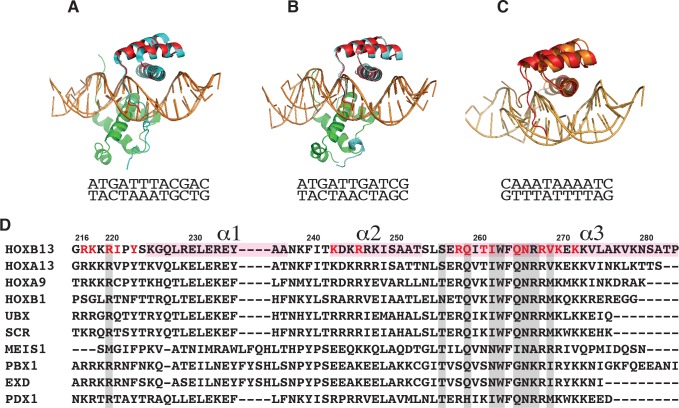
The comparison of HOXB13 structure with HOXB1 and HOXA9.The superposition of HOXB13-DNACAA complex (red) with: (A) HOXA9:PBX1-DNA complex (HOXA9 is in cyan, PBX1 is green, PDB entry 1PUF); (B) with HOXB1:PBX1-DNA complex (HOXB1 is in cyan, PBX1 is in green, PDB entry 1B72); (C) with HOXA13-DNA complex (HOXA13 is in orange, PDB entry 2LD5). The corresponding DNA sequences are presented under pictures. (D) The sequence alignment of Hox proteins with known structures. The numbering corresponds to HOXB13. Three helices are labeled on the top and highlighted with light pink. The residues involved in interactions are highlighted in grey. The residues involved in interaction in HOXB13 are colored red.